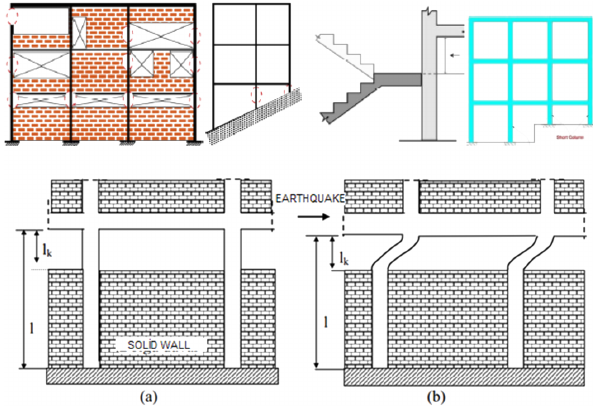
Figure 4. Short column behavior and formations in structures due to various causes.